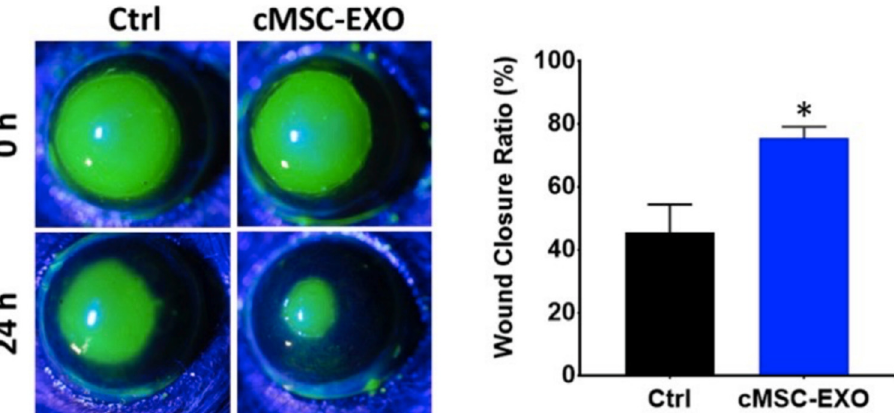
Figure 4. Exosomes from cornea MSCs promote corneal epithelial wound healing. In vivo images using cornea MSC-derived exosomes in corneal epithelial debridement model show the epithelium healing faster when treated with exosomes versus control [126]. * Statistically